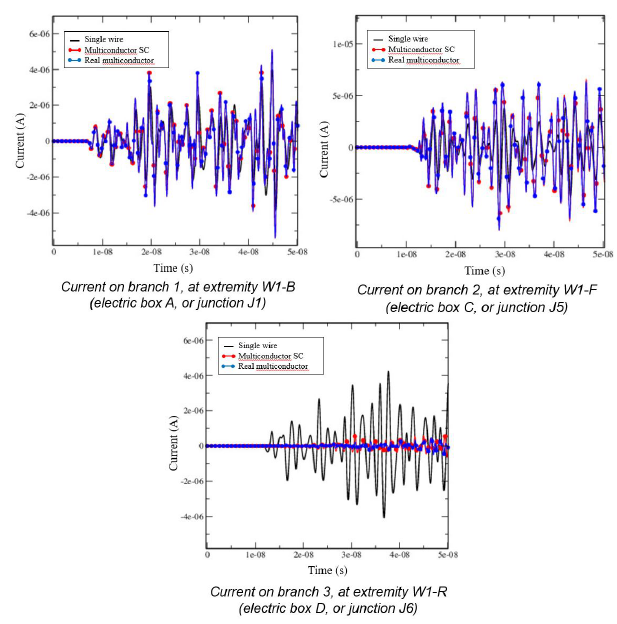
FIGURE 11: Currents on the network branches.